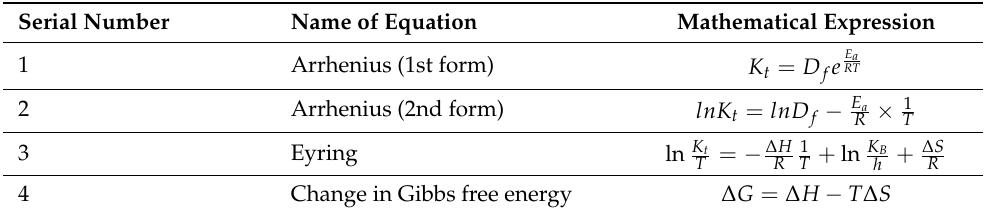
Table 2. Thermodynamic parameters and their respective mathematical